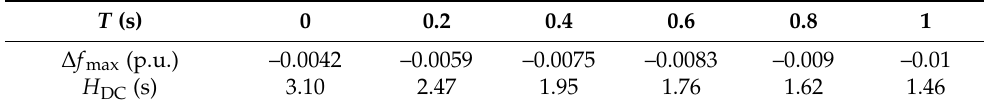
Table 1. Initialization of H DC considering governor